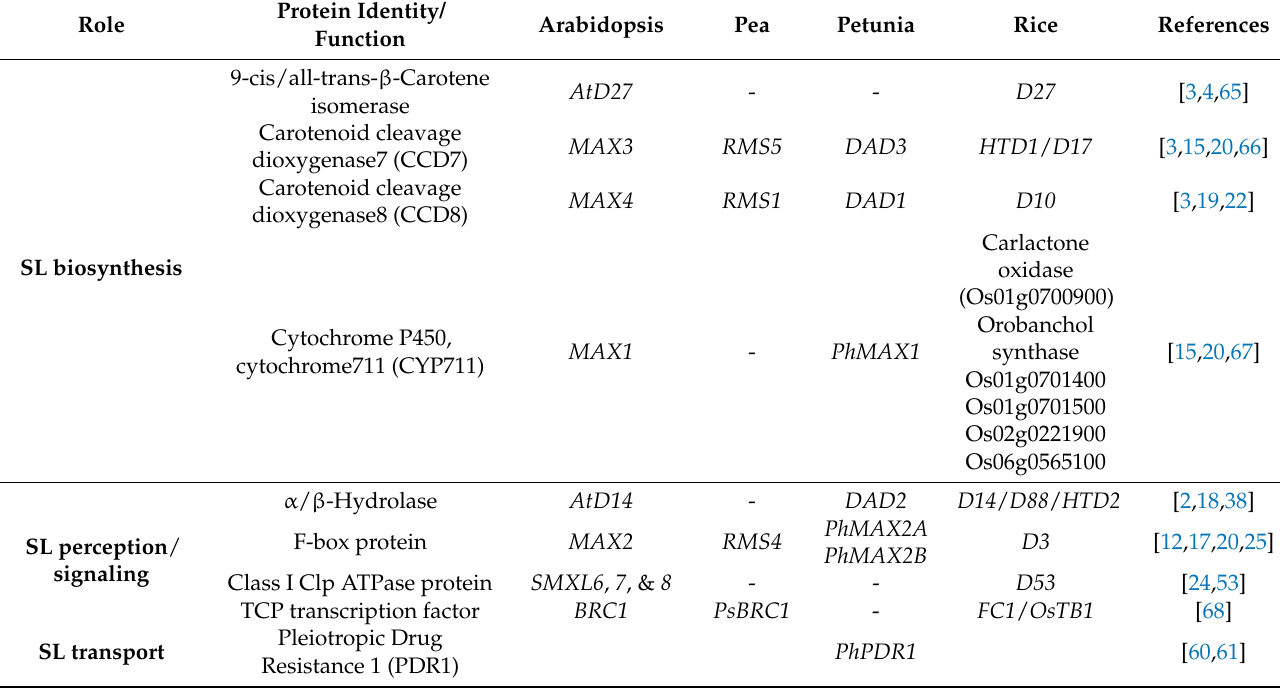
Table 1. Genes involved in strigolactones (SLs) biosynthesis and